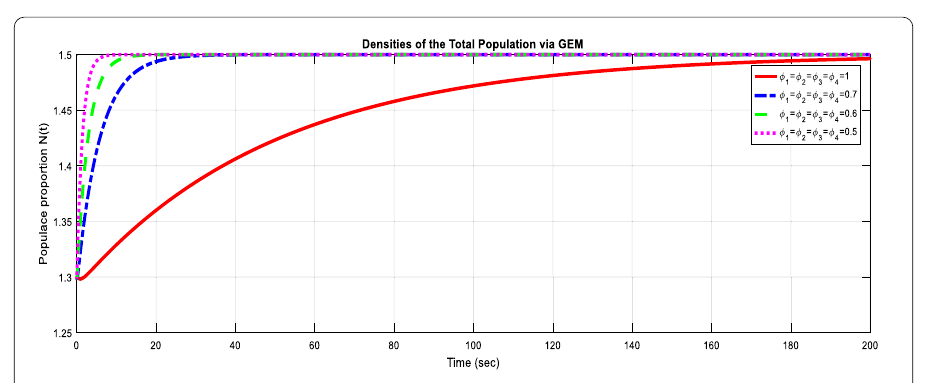
Figure 5 Dynamic of N by varying the value of φ